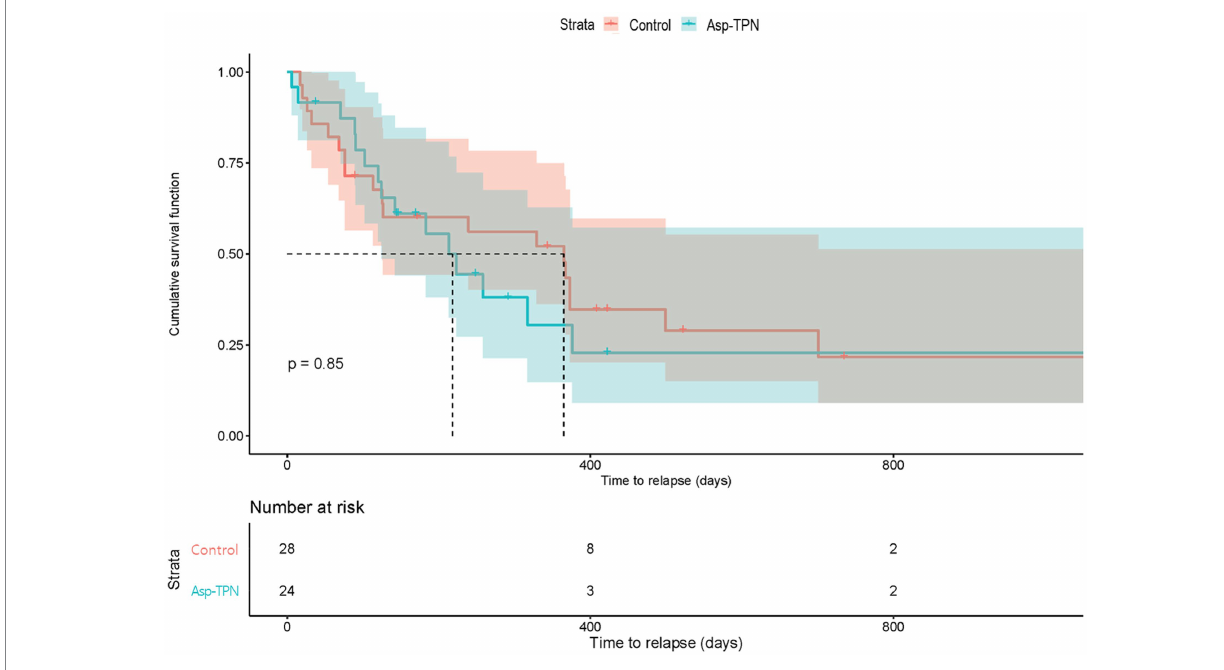
FIGURE 4 Relapse-free survival according to the concomitant use of total parenteral nutrition containing L-aspartic acid. Asp-TPN, aspartic acid-containing total parenteral